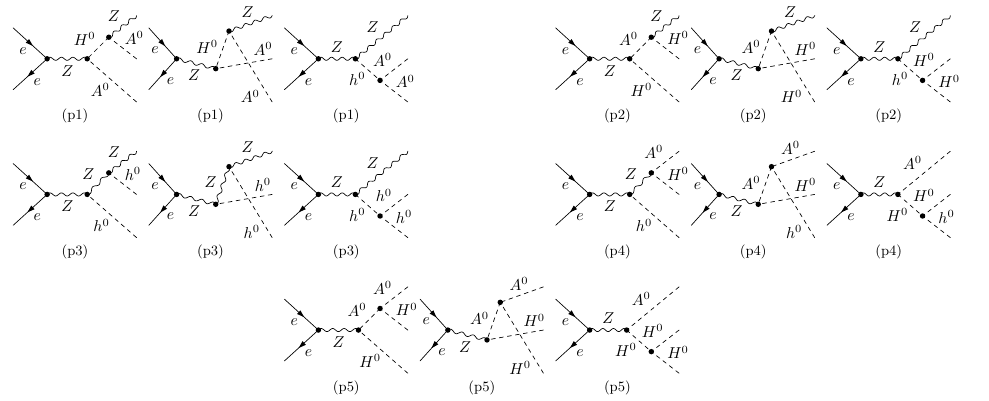
Figure 3 . The set of Feynman diagrams, which contribute to the scattering process given in table 2, with the caption indicate which scattering p rocess it belongs to. For example; p1 stands for the (cid:12)rst process in the top row ( e (cid:0) e + ! Z 0 A 0 A 0 ) in table 2. It should also be noted that the calculation is carried out in the Feynman gauge, and there are the same set of diagrams with a Goldstone boson ( G 0 ) which is intermediated instead of a vector